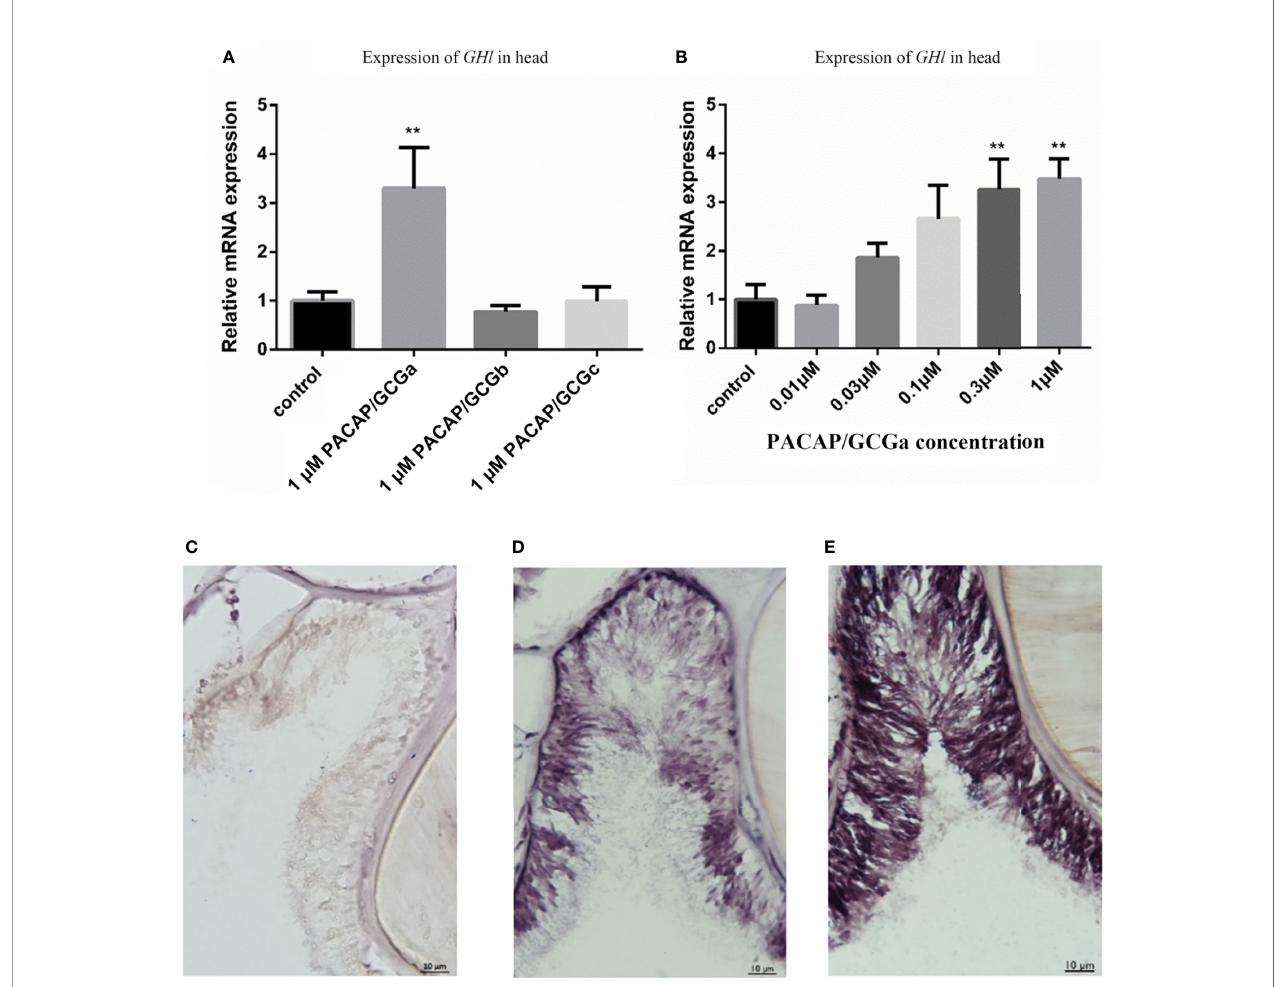
FIGURE 7 | Stimulation of GHl expression by exposing B . belcheri to PACAP/GCGa peptide. (A) Potency of the three cephalochordate PACAP/GCGs peptides in GHl expression. The synthetic B. fl oridae -predicted peptides were used, and they share >96% amino acid sequence similarity with B . belcheri orthologs. B . belcheri PACAP/ GCGa (BbPACAP/GCGa) is 100% identical in amino acid sequence to B . fl oridae ortholog (BfPACAP/GCGa). Gene expression levels were determined by quantitative PCR and normalized using the ef1a expression as reference. (B) Changes of GHl gene expression levels to different concentrations (0.01 to 1 m M) of BbPACAP/GCGa peptide. Data represent the result of two independent experiments ( n = 3/experiment) and are expressed as means ± SEM. Statistical signi fi cant differences were assessed using one ‐ way ANOVA followed by the Dunnett ’ s test. ** p ≤ 0.001. (C – E) Digital images showing GHl expression detected by in situ hybridization in the B. belcheri Hatschek ’ s pit: (C) negative control, (D) after high salinity challenge (35 ppt for 72 h), and (E) after high salinity challenge and exposure to 1 m M BfPACAP/GCGa. Intense staining was observed in the presence of the BfPACAP/GCGa peptide. The scale bar is 10 m m and is indicated in the